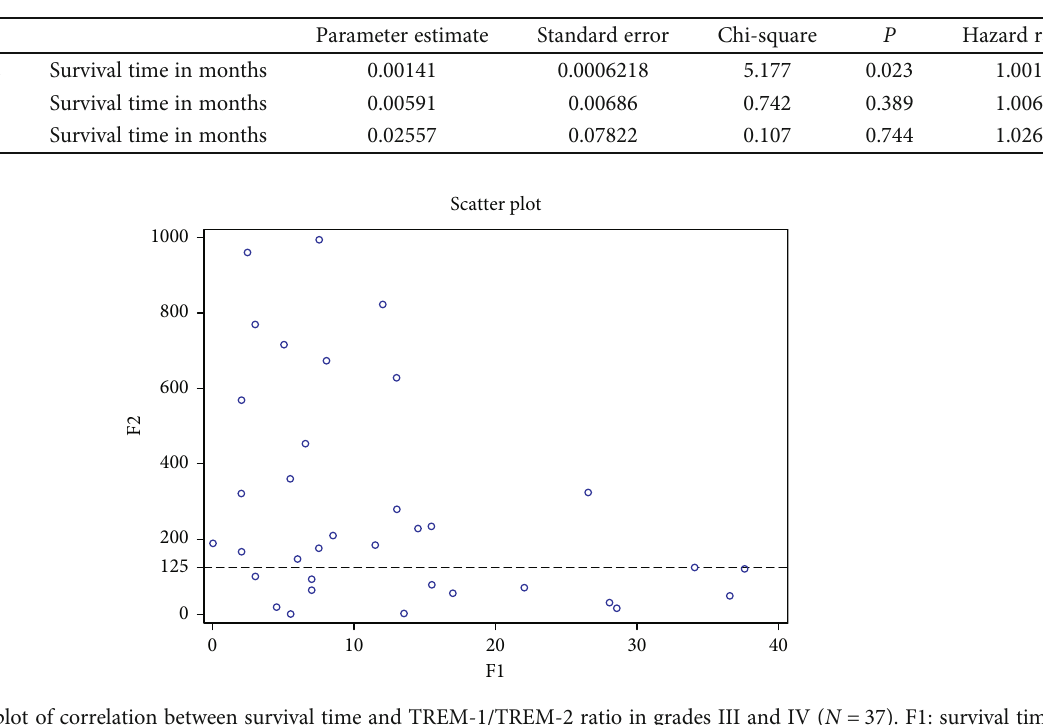
Table 2: Cox proportional hazard analysis of TREM expression and survival time in high-grade gliomas.